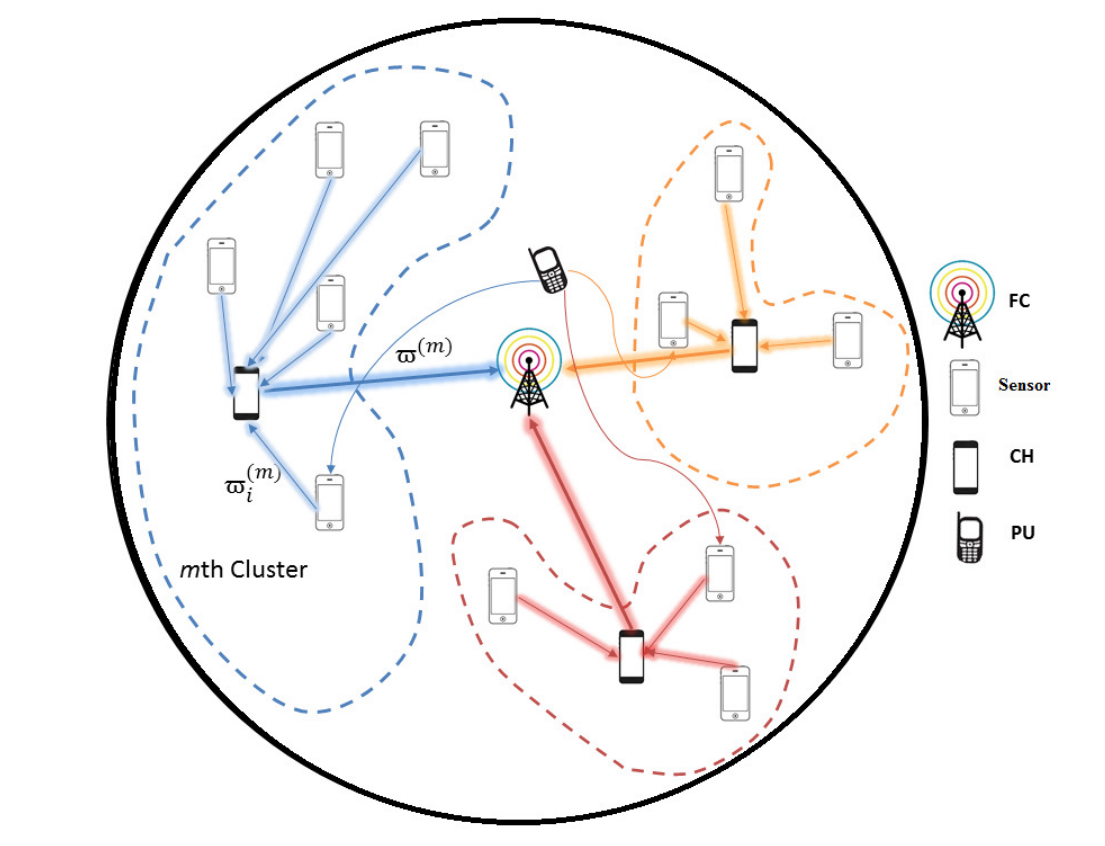
Figure 2. System